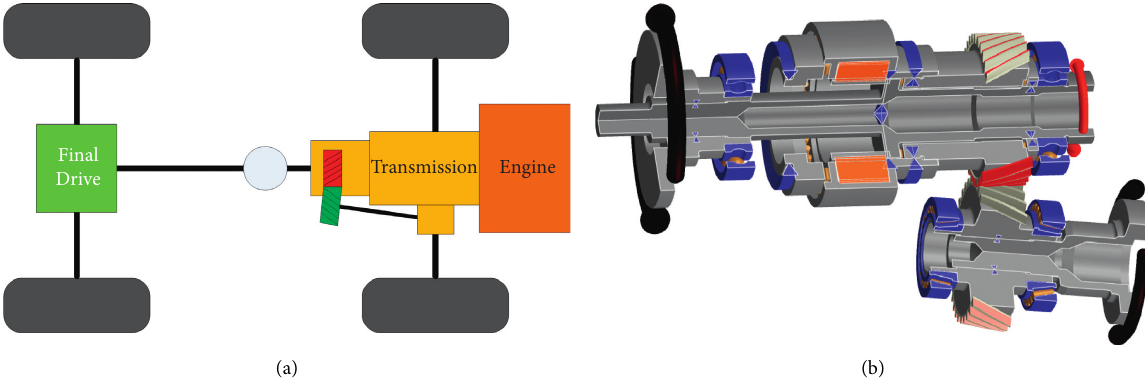
Figure 1: Application and 3D models of small shaft angle beveloid gear. (a) Application in an AWD vehicle. (b) Transfer